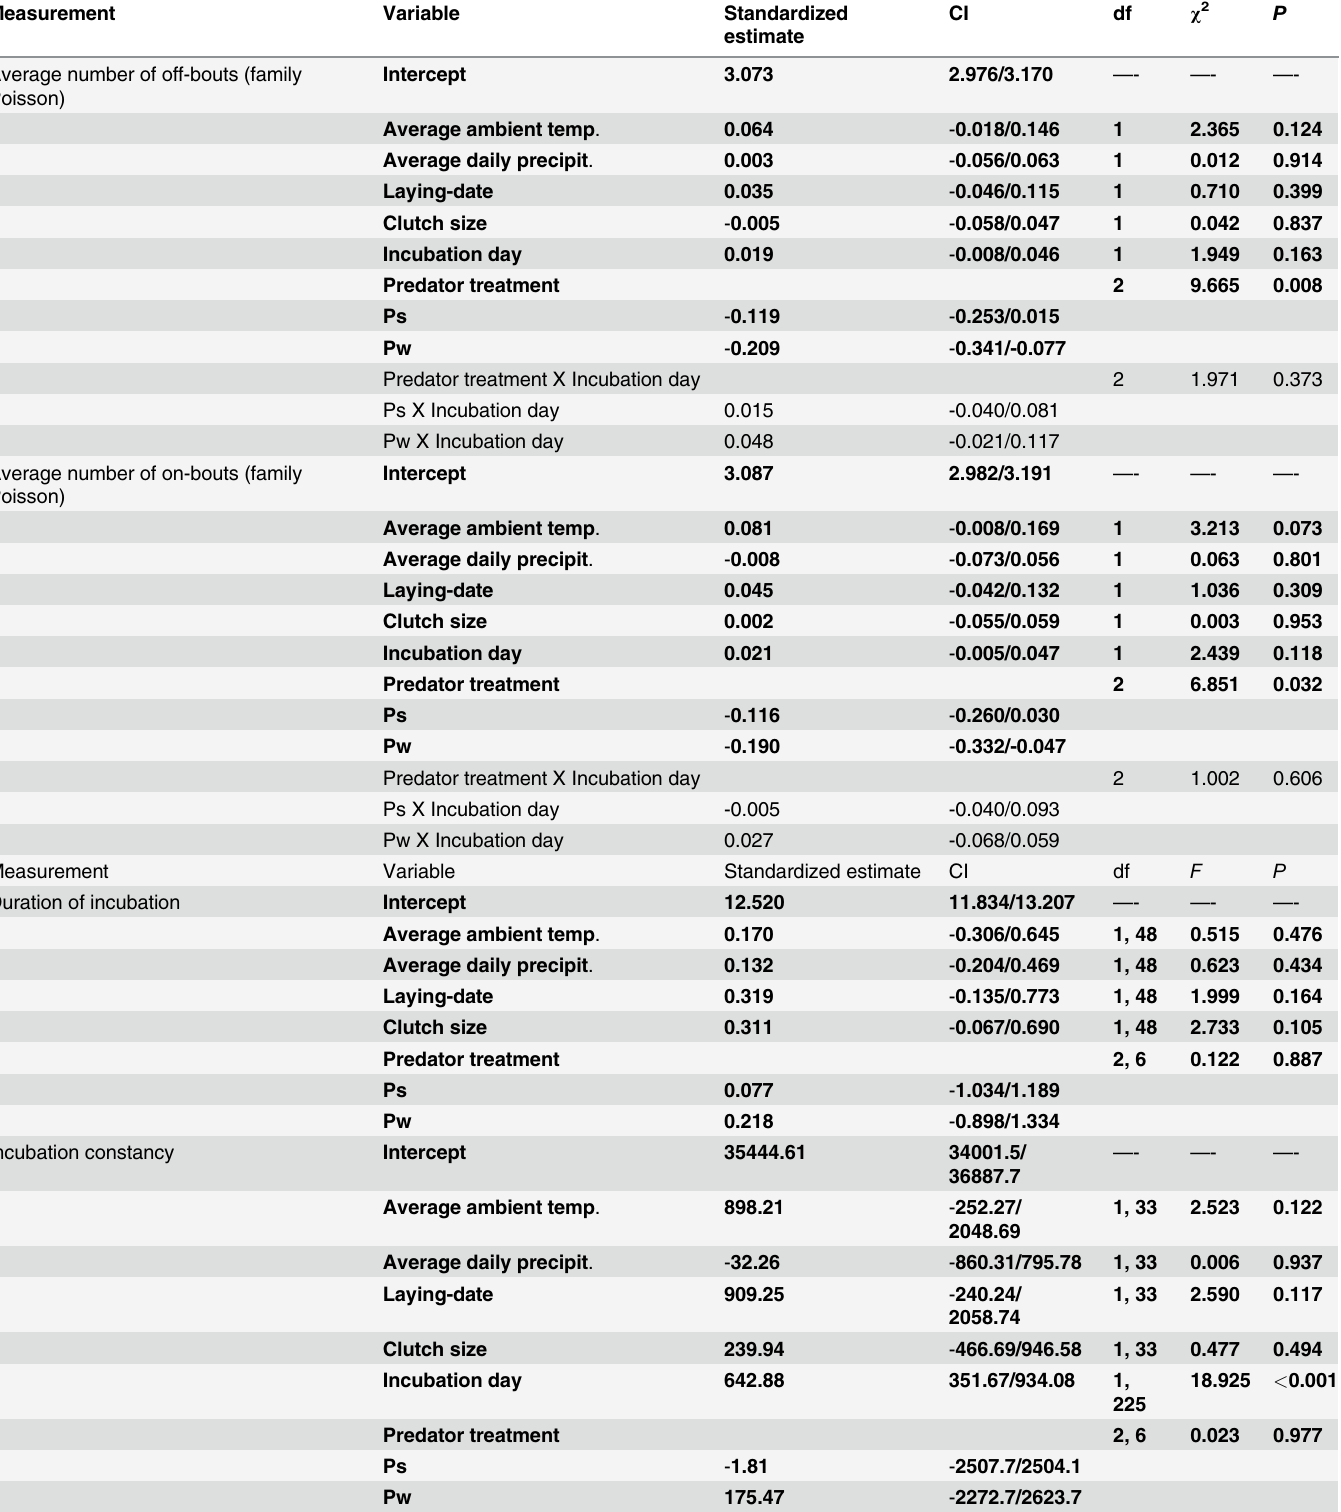
Table 1. ANOVA table of LMMs and GLMs for incubation